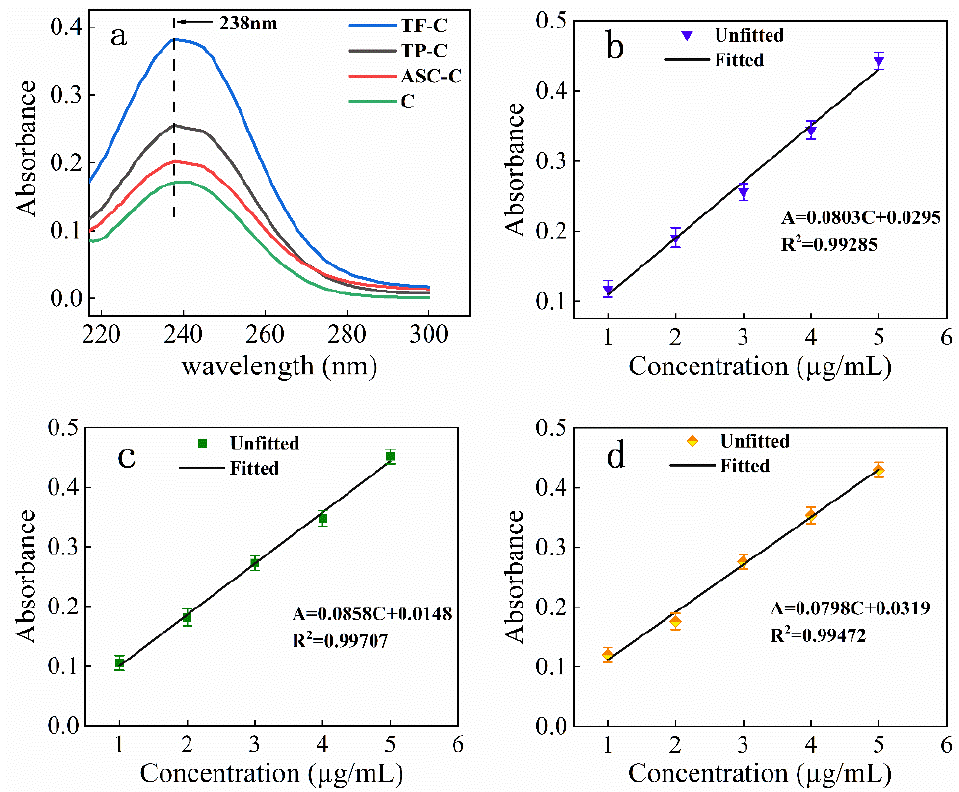
Figure 1. UV absorption spectrum of antioxidant-modified citral. ( a ) UV spectra of citral, tea-polyphenol–citral, ascorbic-acid–citral, theaflavin–citral, ( b ) standard curves of tea-polyphenol–citral, ( c ) standard curves of ascorbic-acid–citral, ( d ) standard curves of theaflavin–citral.